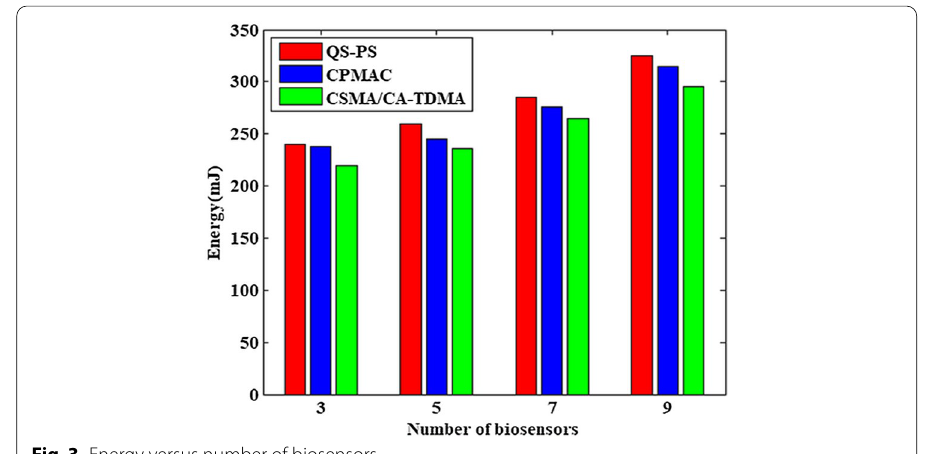
Fig. 3 Energy versus number of